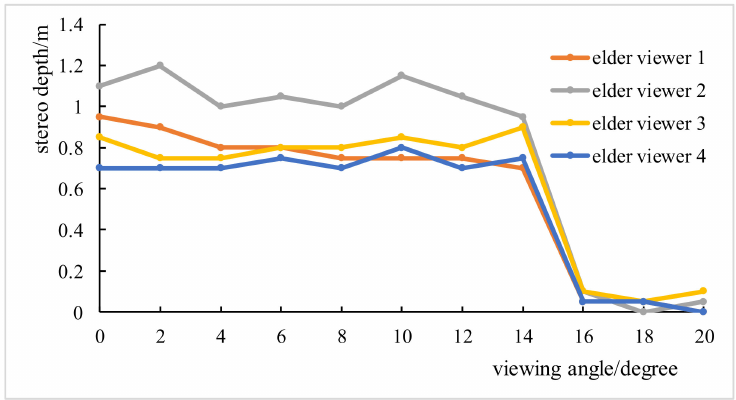
Figure 11. Perceived stereo depth of “lotus” on the prototype at different viewing angle by 4 different elder